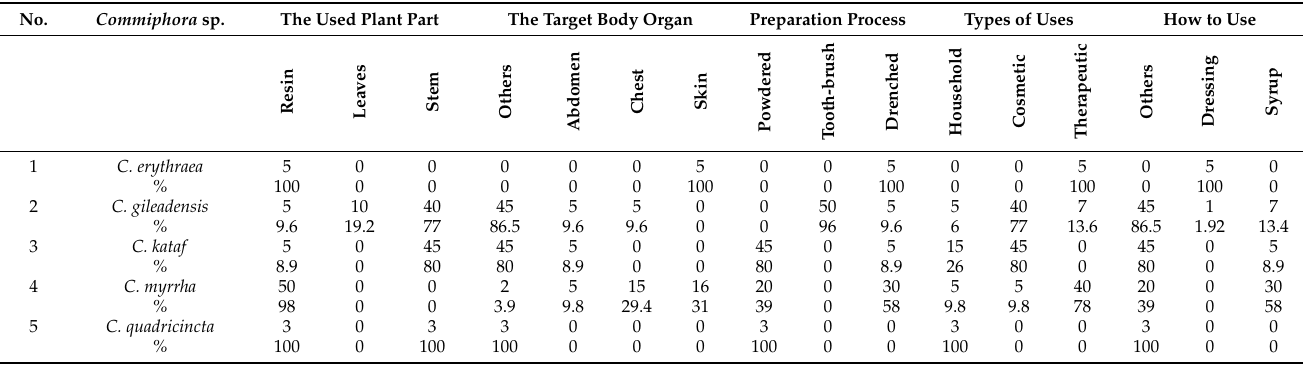
Table 9. Analysis of ethno-botanical aspects, percentage values according to the FC, where Fc is the number of respondents who cited a particular species.